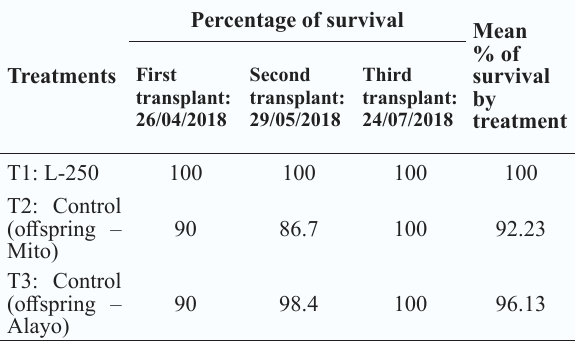
Table 4. Survival rate of three transplant periods (April, May, and July), in evaluation assay of clonal thorny artichokes, Santa Ana Junín EEA and Alayo Annex, Concepción Province,